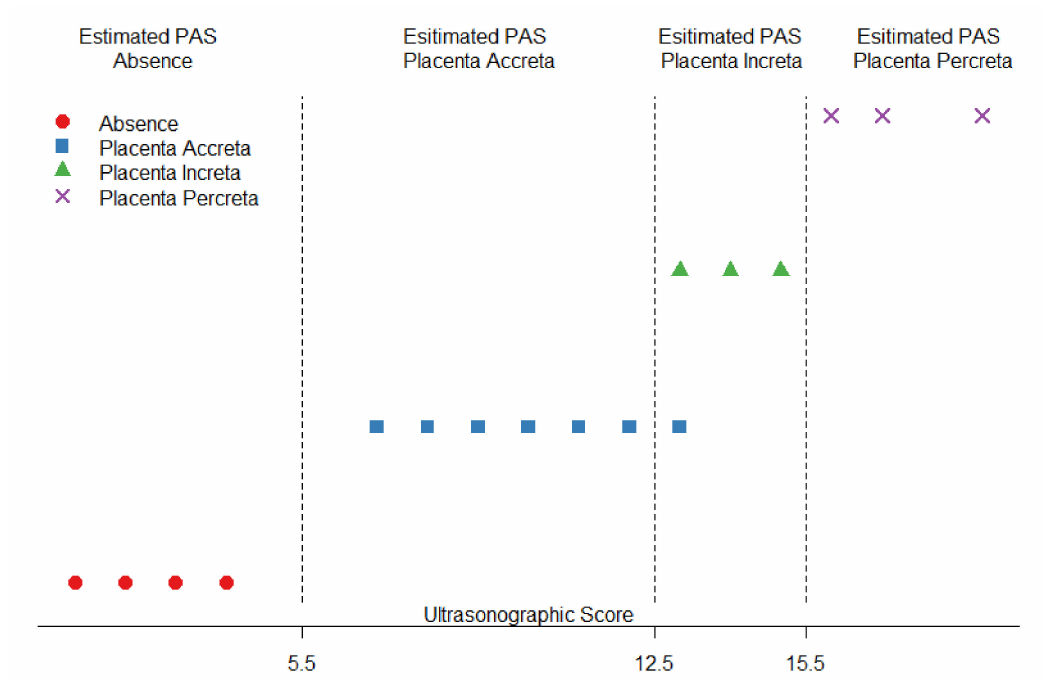
Figure 1. Estimated vs. actual diagnosis according to the proposed score.